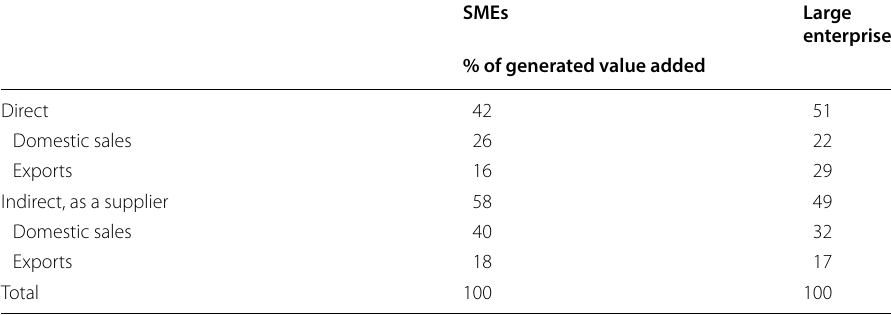
Table 4 Output structure of SMEs and large enterprises, 2012 SMEs Large